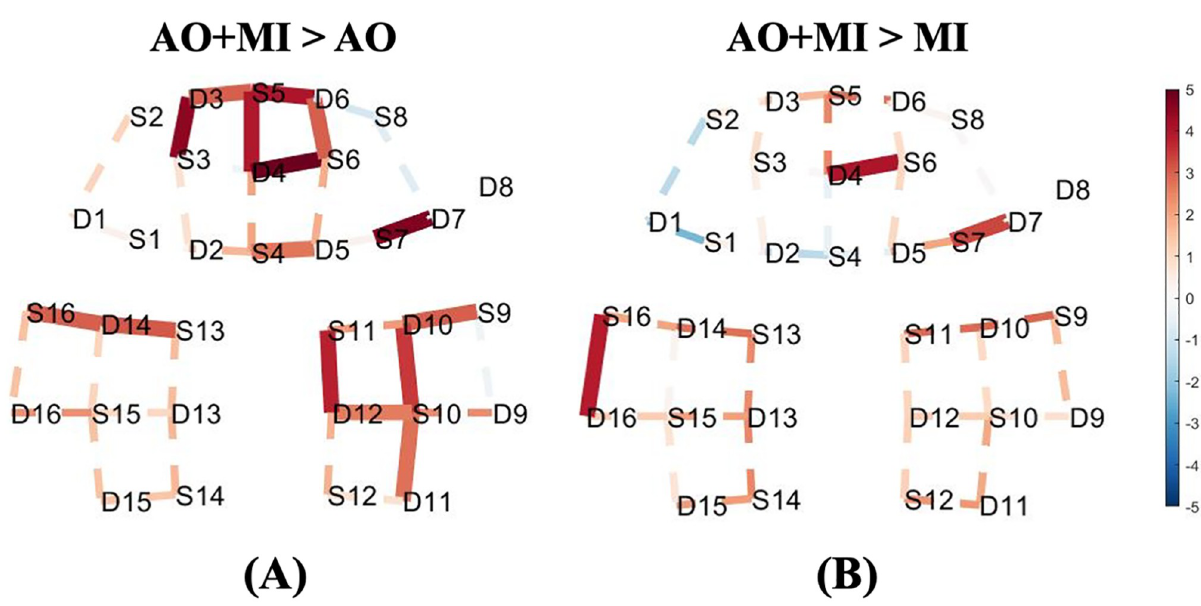
Fig 6. T-map of oxy-hemodynamic response (HbO) corresponding to the contrast between (A) AO + MI and AO experiments, (B) AO + MI and MI experiments of the dynamic standing task. Significantly activated channels at p < 0.05 (FDR corrected) are indicated by thick, solid lines, red colour indicates stronger activity from AO + MI experiment than the AO experiment in (A) and MI experiment in (B) . The dashed line shows the channels that were not statistically significant. This map was generated by using NIRS Brain AnalyzIR Toolbox [51]. Fig 2 illustrates the referencing for the brain regions with 10–20 EEG system